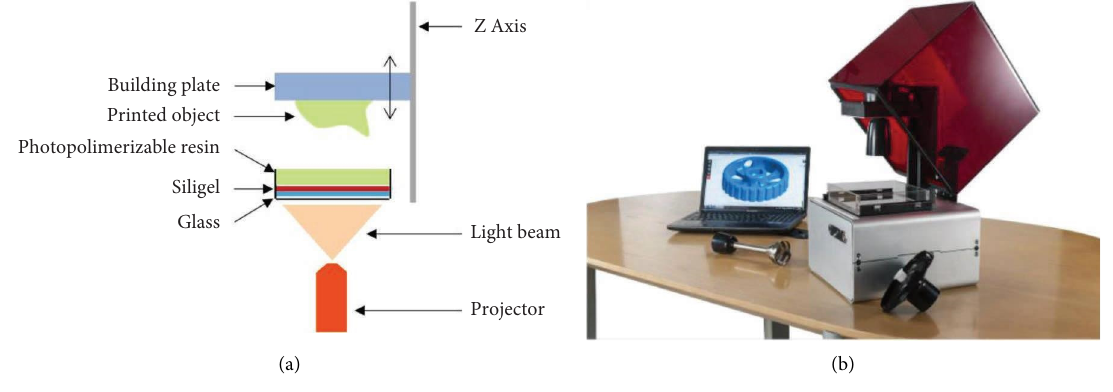
Figure 9: SL printing principle (a) and equipment